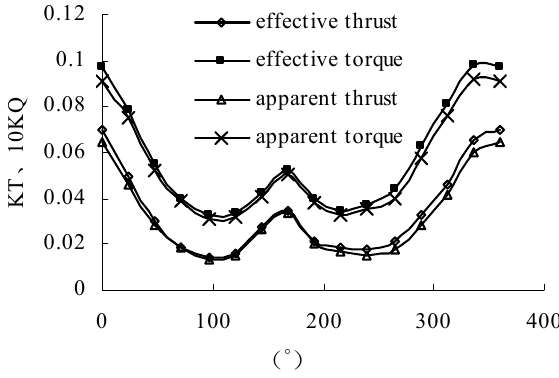
（ ° ） （ ° ） Figure 6. Thrust and torque of the key blade. Figure 6. Thrust and torque of the key Figure 6. Thrust and torque of the key blade.